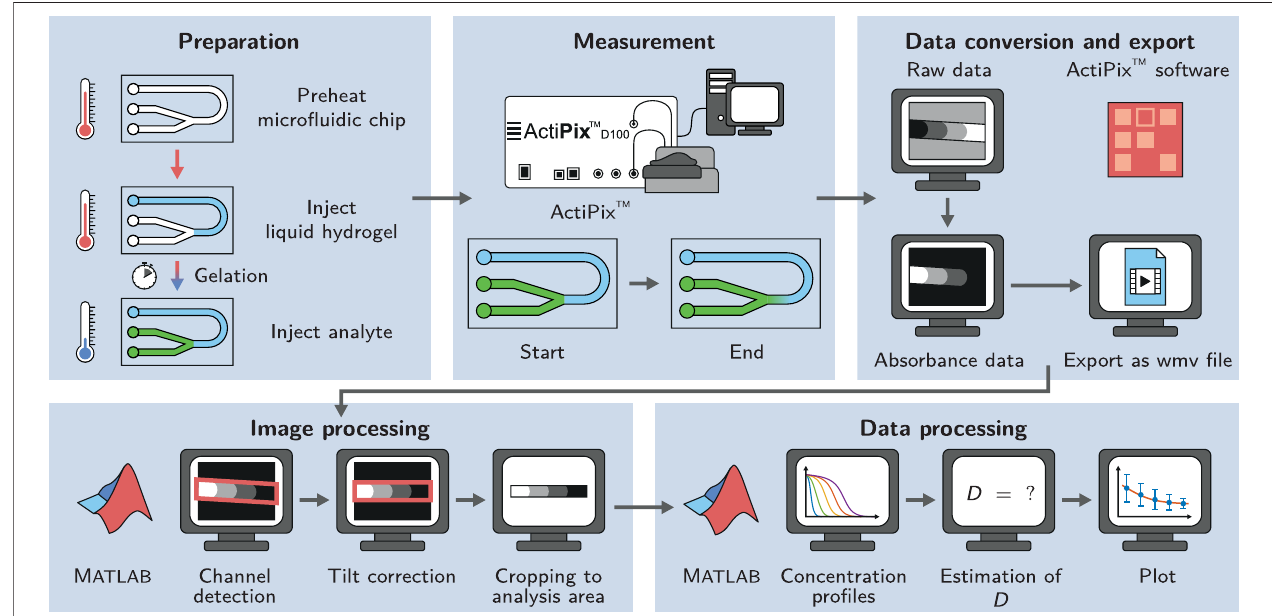
FIGURE1| Schematicofthework fl owappliedinthisstudy.Themicro fl uidicchipispreheatedtoallowtheinjectionofliquidagaroseintothechannelandensurethe controlled gelation by cooling at room temperature. The diffusion measurement is started right after the injection of the analyte. The acquired data is converted and exported using the ActiPix ™ software. Image and data processing for the estimation of diffusion coef fi cients is done in MATLAB .